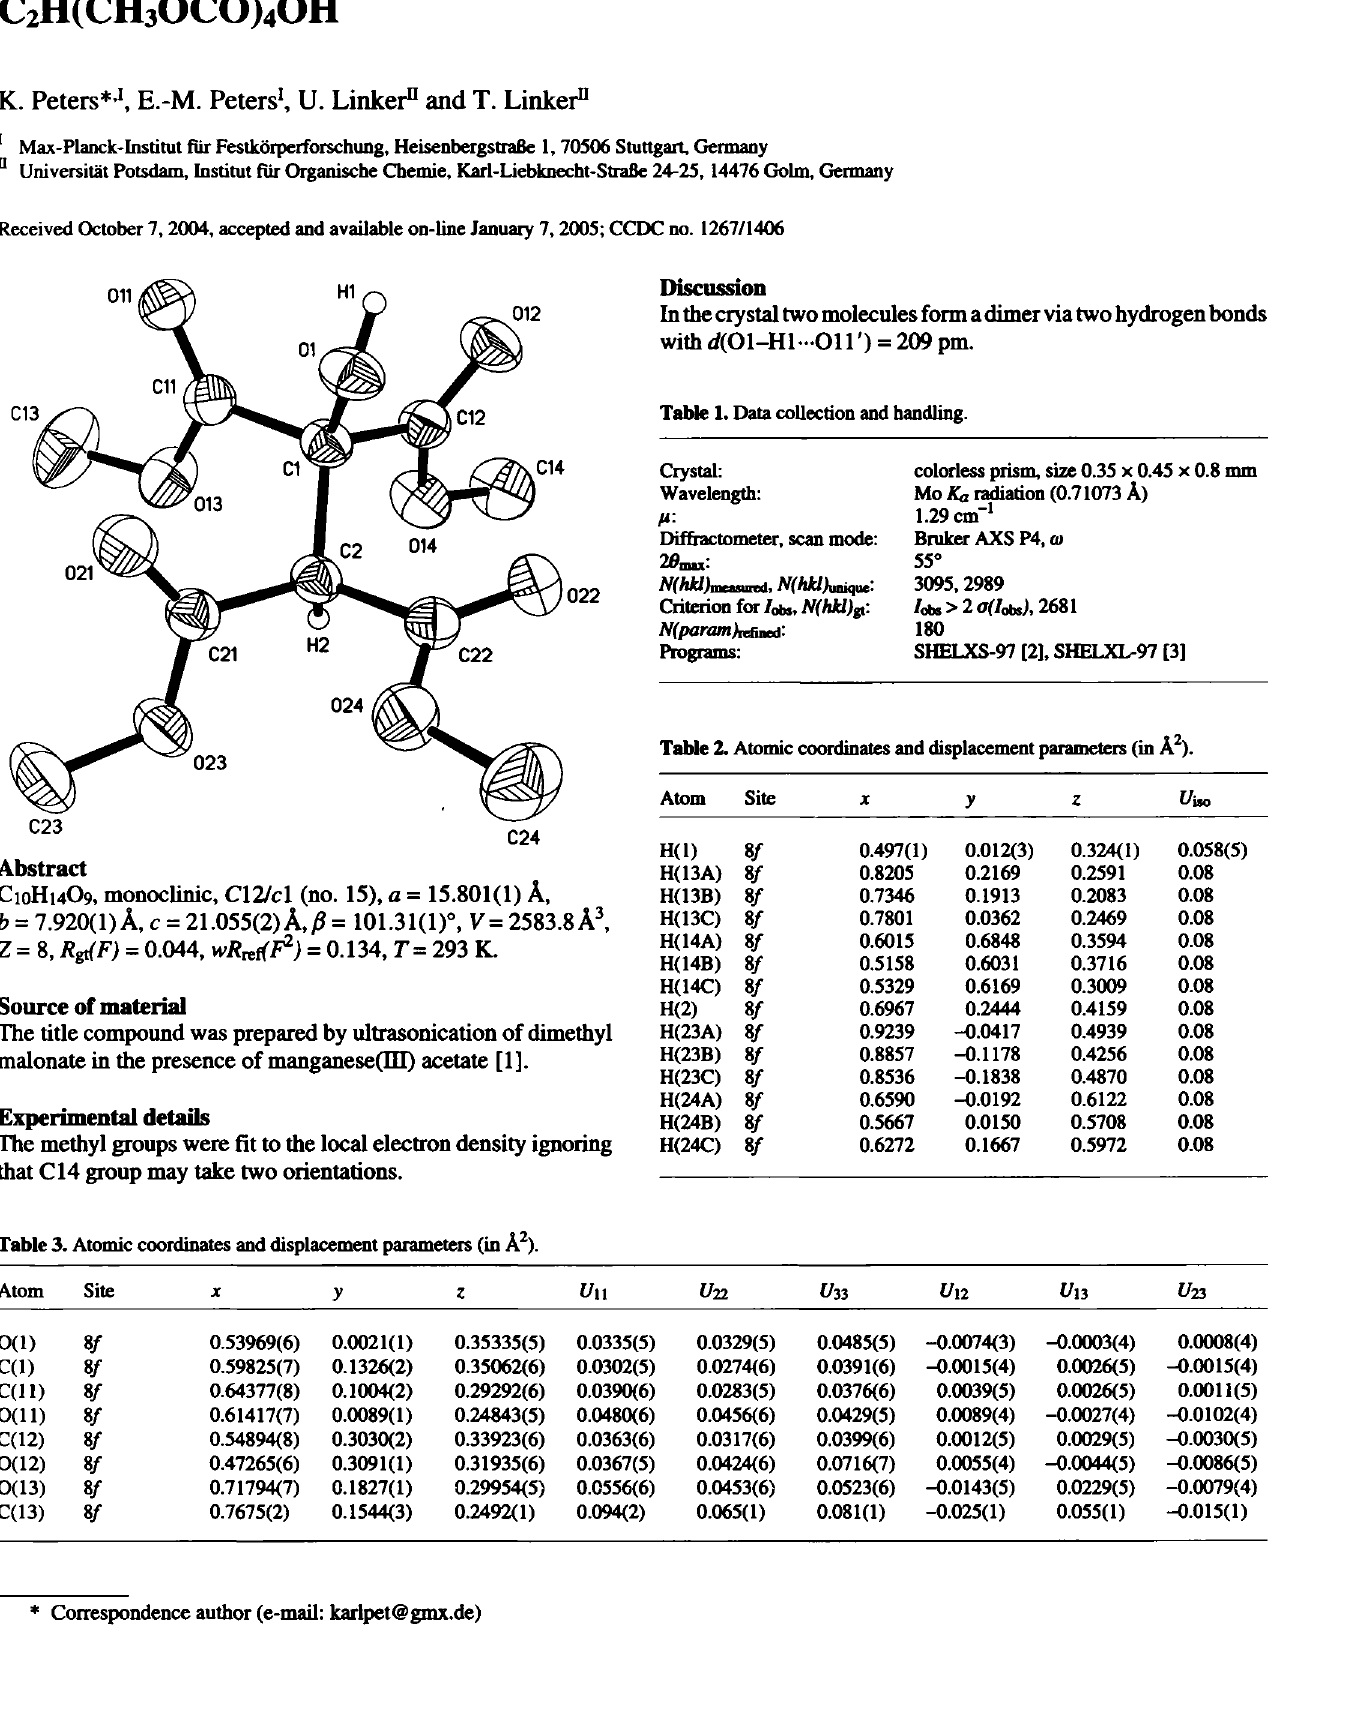
Table 1. Data collection and handling.